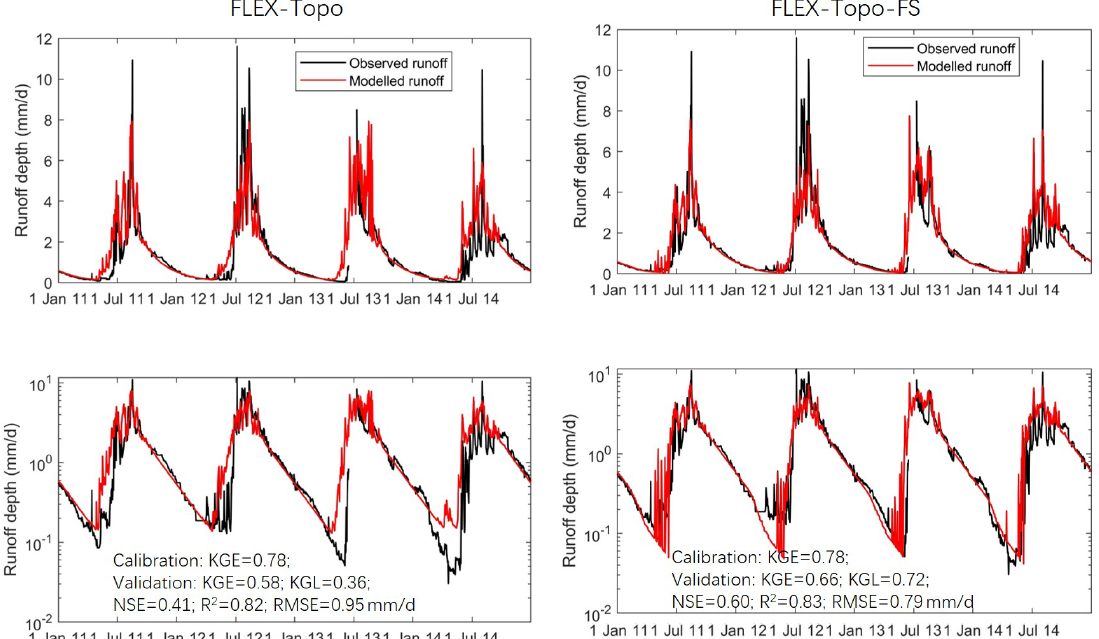
Figure 10. Modeling results of FLEX-Topo and FLEX-Topo-FS models and the comparisons with observation on both normal and logarith- mic scales.